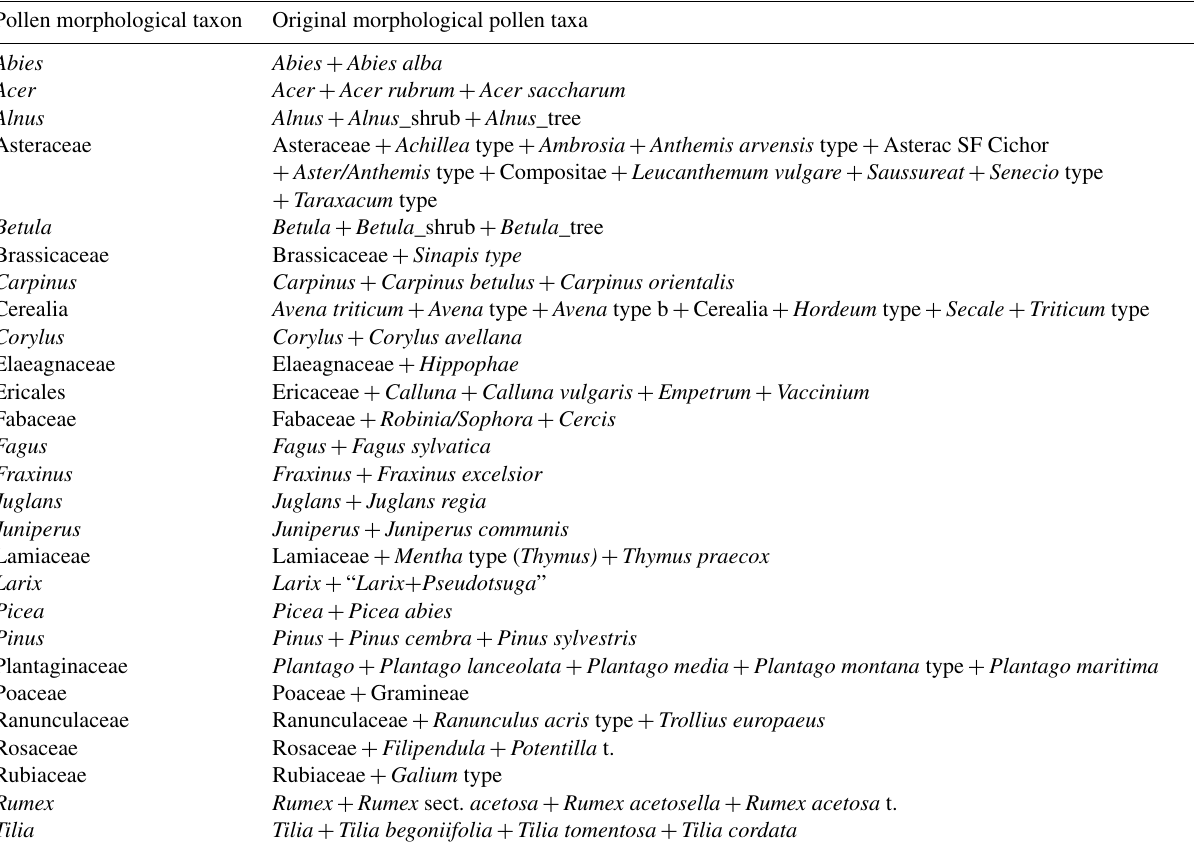
Table 2. Combination of taxonomic levels. Note “t.” denotes